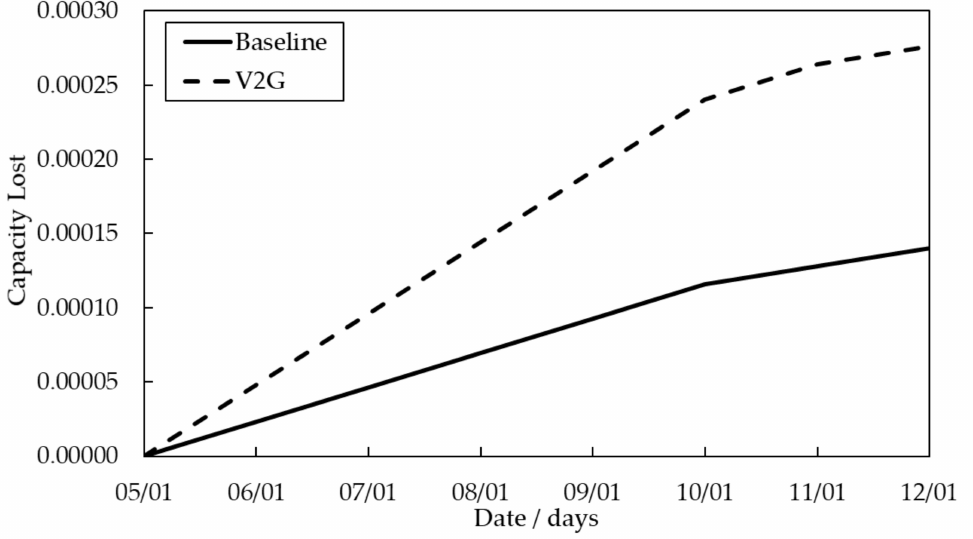
Figure 6. A graphical representation of the cumulative increase in total capacity lost across a